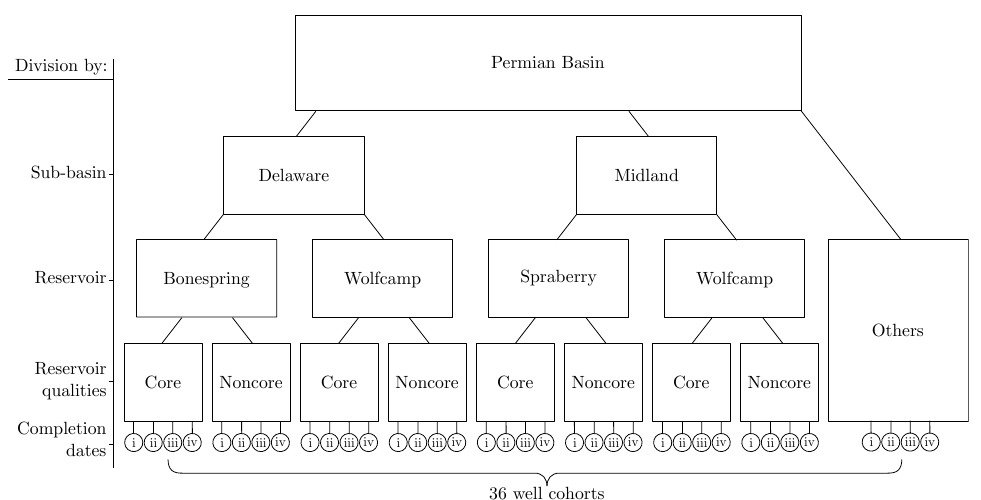
Figure 4. The 53,708 horizontal wells completed in the Permian tight reservoirs are divided into 36 well cohorts based on reservoir quality and completion date intervals.